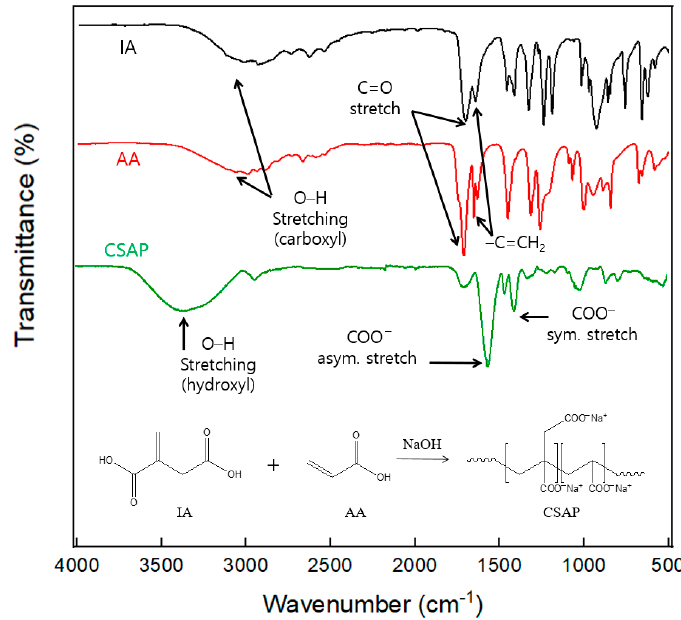
Figure 2. FT-IR spectra of IA, AA, and CSAP.